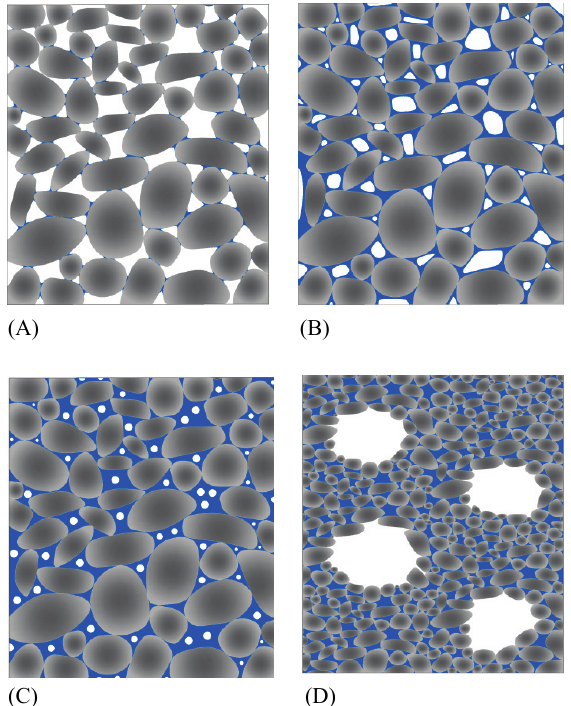
Fig. 4. Schematic representation of micro-structure of saturation: